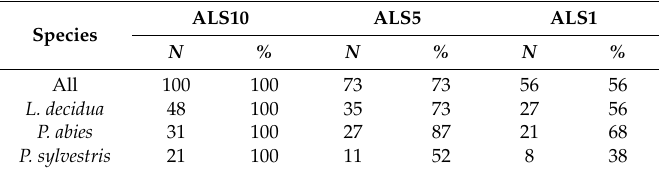
Table 2. Total number (N) and percent value of detected trees by ALS from the original dataset of felled trees. ALS data are presented divided by pulse densities (10, 5, 1 points/m 2 ) obtained through point cloud thinning.